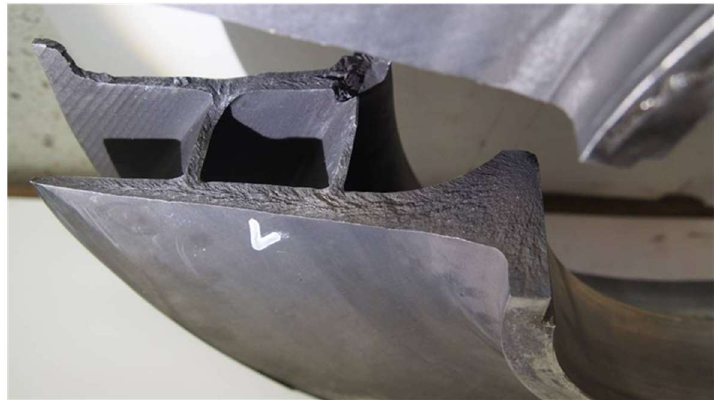
Figure 1. Failed impeller of the first stage.